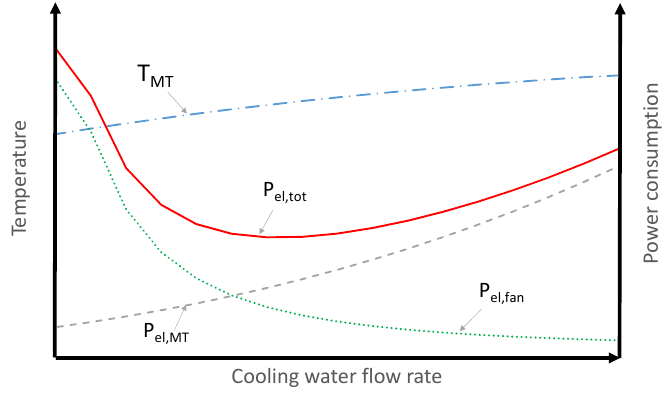
Figure 2. Principle of heat rejection control optimization mode 3 (at given ˙ Q LT , req , T HT , T LT , T wb , ˙ V HT and ˙ V LT ).